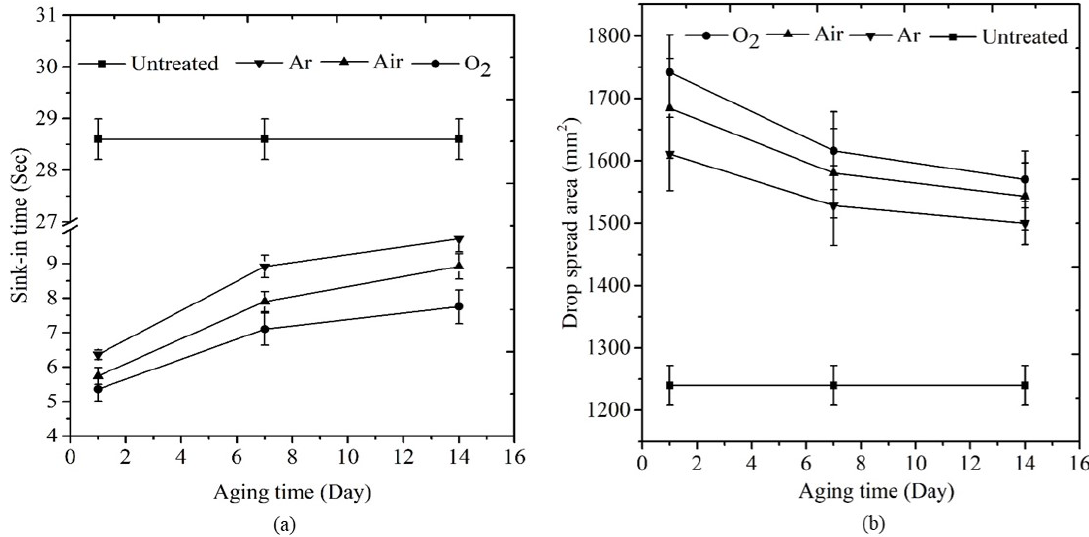
Figure 6. Evaluation of aging effect on plasma treated fabric by sink-in time (a) and drop spread area (b).